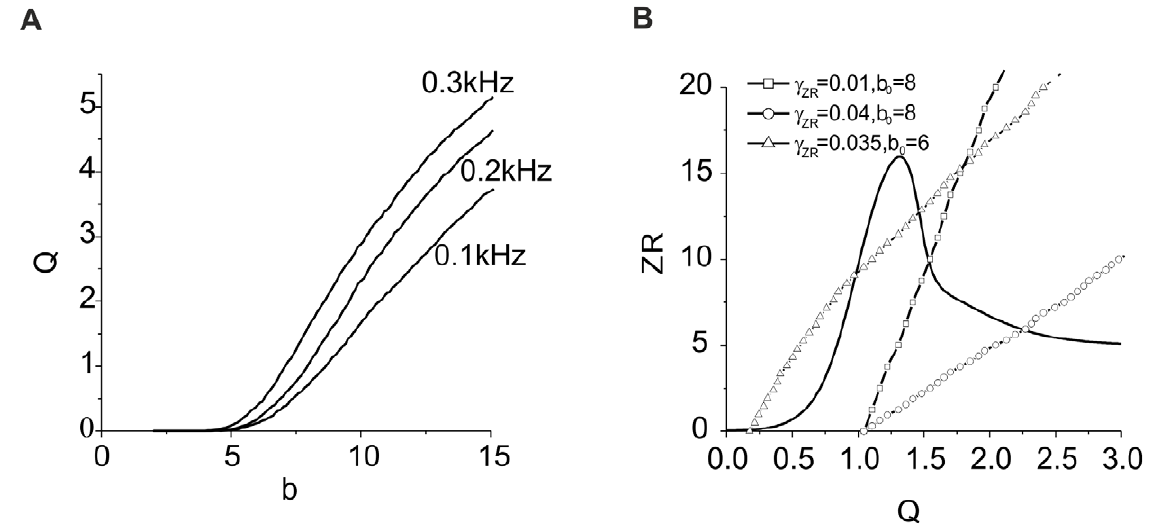
Figure 9. Characteristics of ECM receptor regulation cascade. A. Average dependence of activity on the strength of synaptic input for different Poisson frequencies. B. Equilibrium curves illustrating the solutions of Eqs. (17) for different ECM receptor feedback gains. Parameter values: k q =0.01, a q =0.0001 msec 2 1 , b q =0.01 msec 2 1 , I 0 =4.5, b 0 =6, c P =0.01, c Z =0.0, and c ZR =0.01,0.04,0.035.